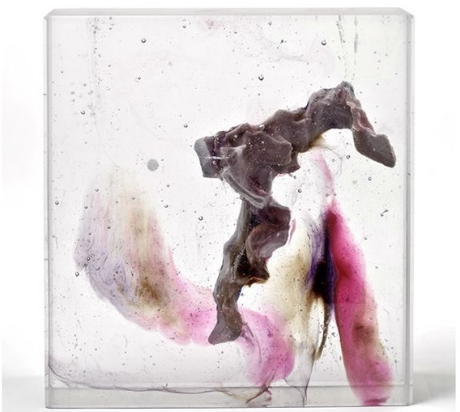
Figure 12. Antoine Leperlier; Verriales , 2013; glass with a bone china inclusion; photo credit: Serge Lechaczynski, used with permission.